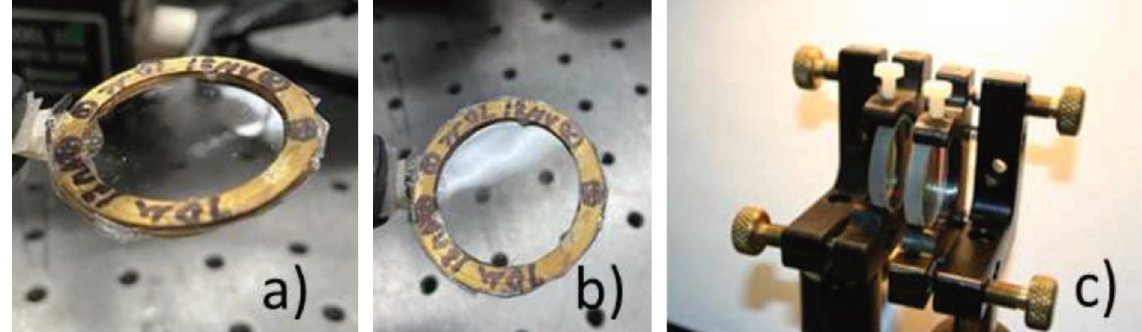
Figure 4: (a), (b) Metallic O-ring with a diameter of about 4cm and thickness of 1 mm. A thin gelatin flm was glued to the ring. (c) Fabry- Perot with two high refecting mirrors.